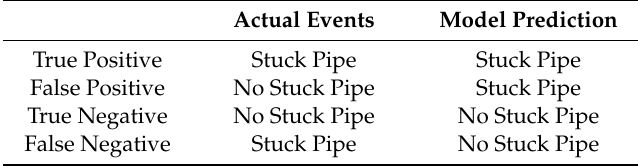
Table 6. Confusion matrix of actual events against predicted stuck